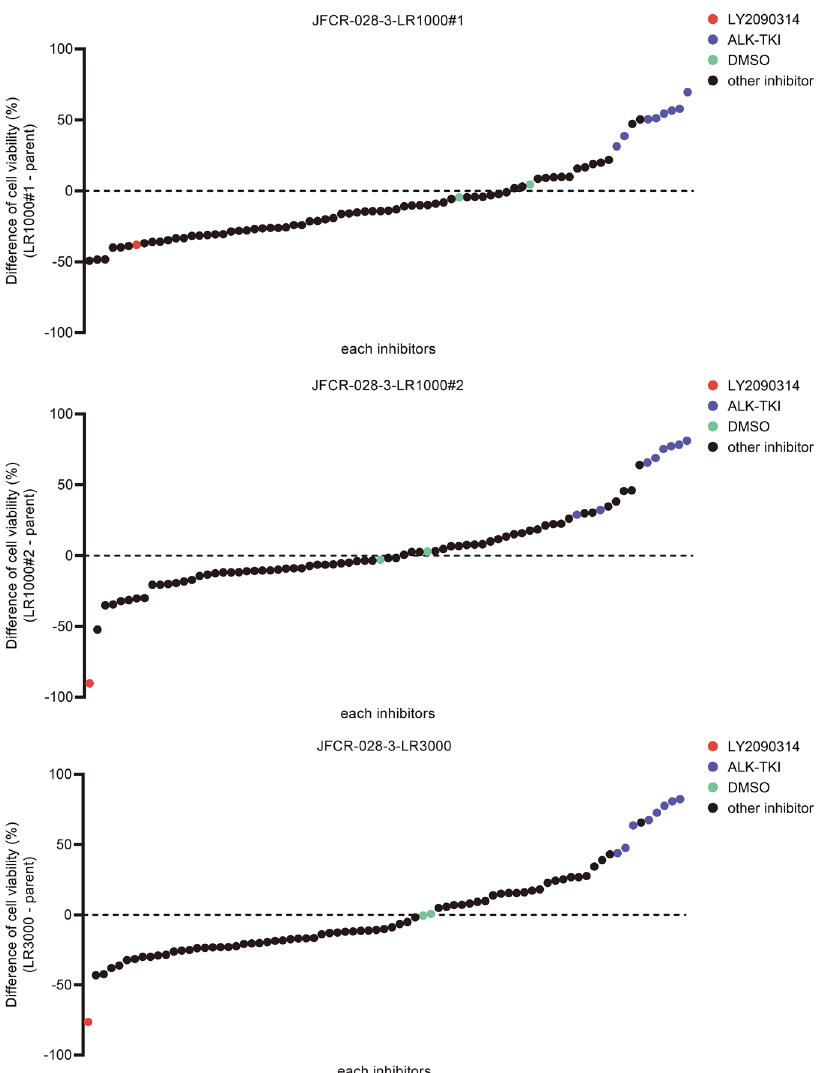
Fig. 2 Focused inhibitor library screening revealed that GSK3 inhibitors speci fi cally suppressed lorlatinib intermediate resistant cell viability. Difference in drug sensitivity to each drug between JFCR-028-3 lorlatinib intermediate resistant cells and JFCR-028-3 parental cells. The difference of drug sensitivity was calculated from the cell viability of JFCR-028-3 lorlatinib intermediate resistant cells and JFCR-028-3 parental cells in each drug ( n = 2). Relative cell viability was calculated from each value divided by the DMSO